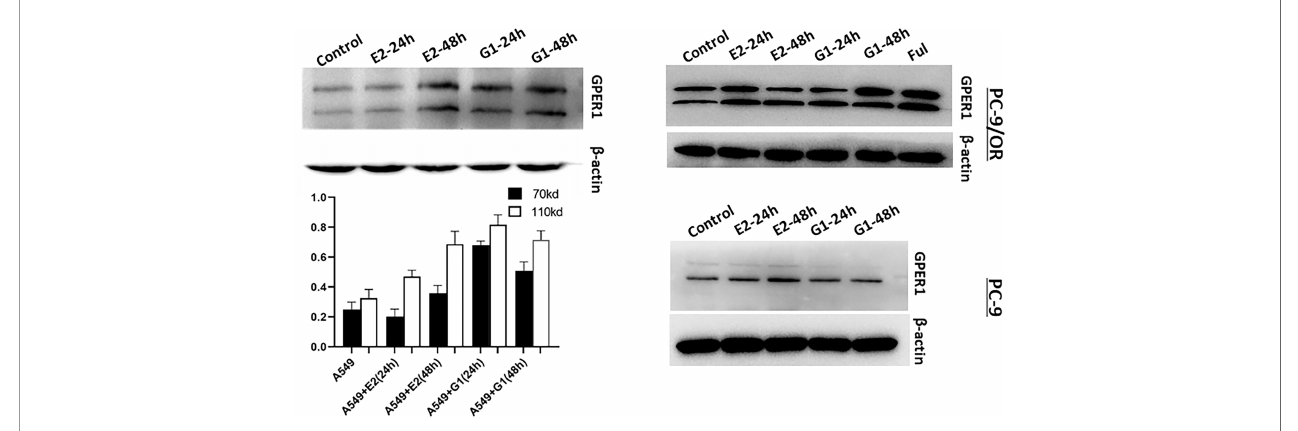
FIGURE 4 | Estradiol (E2), G1 and fulvestrant (FUL) upregulated the expression of GPER1. The activity of GPER1 was stronger in PC-9/OR and A549 cells than in